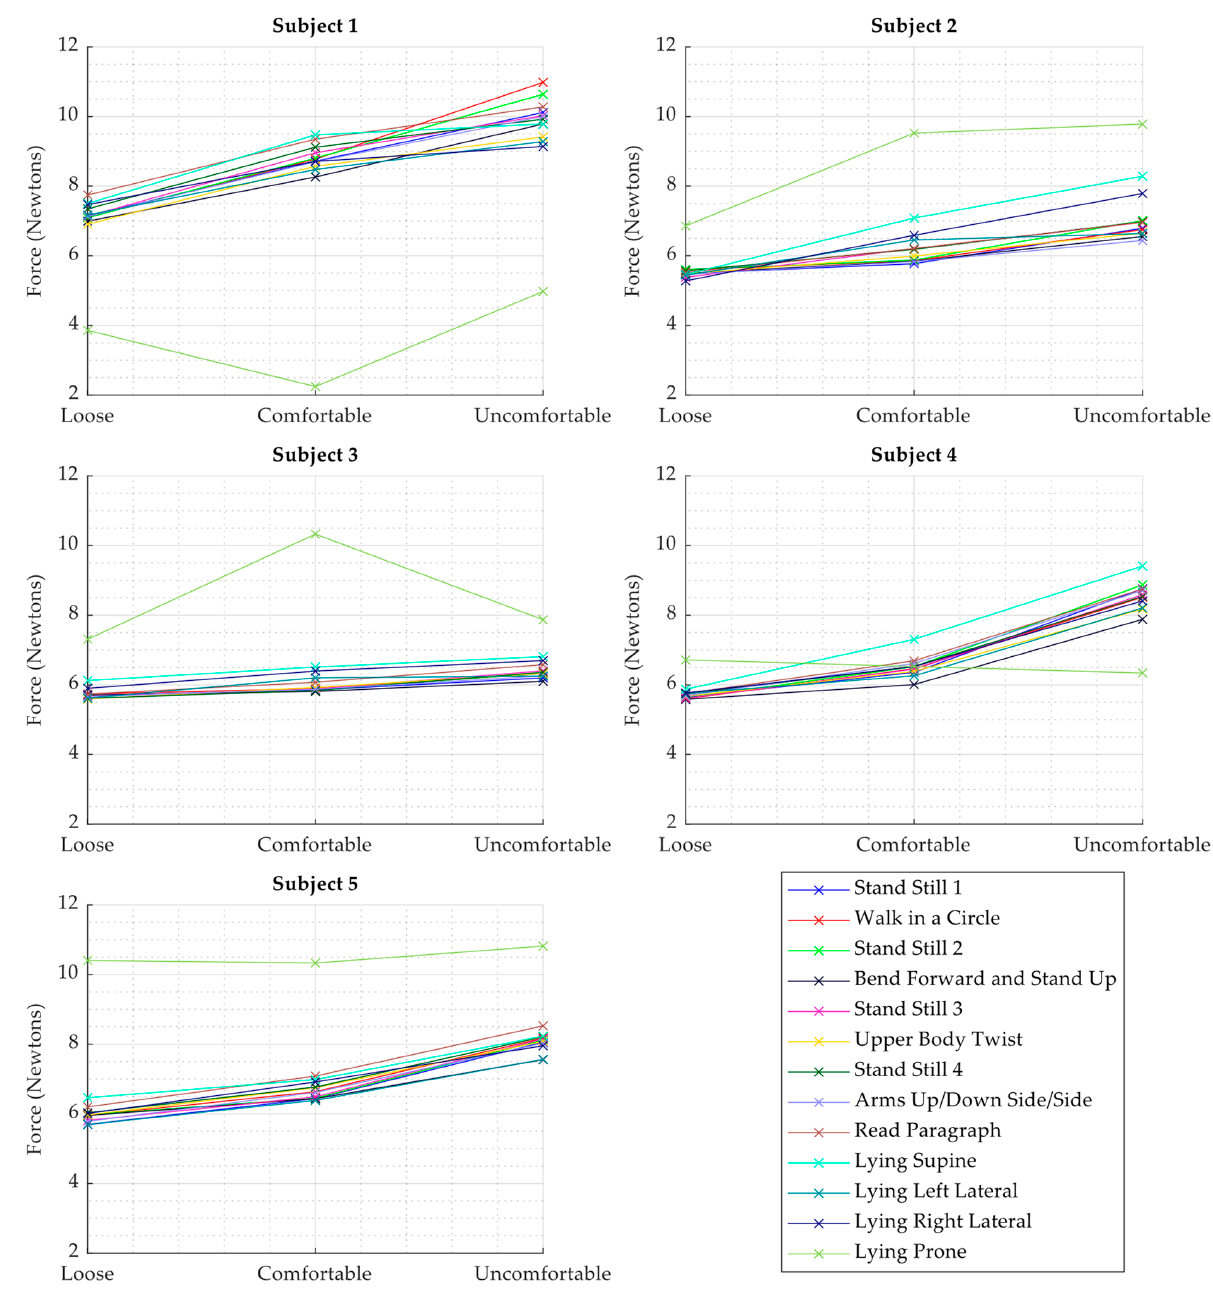
Figure 10. Force RMS vs. WPAS tightness levels for all subjects across activities. The ensemble medians for each activity and each subject were computed. The RMS values of the heart sounds were determined from the ensemble medians for each subject and activity. Figure 11 presents the results of the computation of the ensemble medians for the three levels of tightness for the Stand Still 1 activity for each subject.